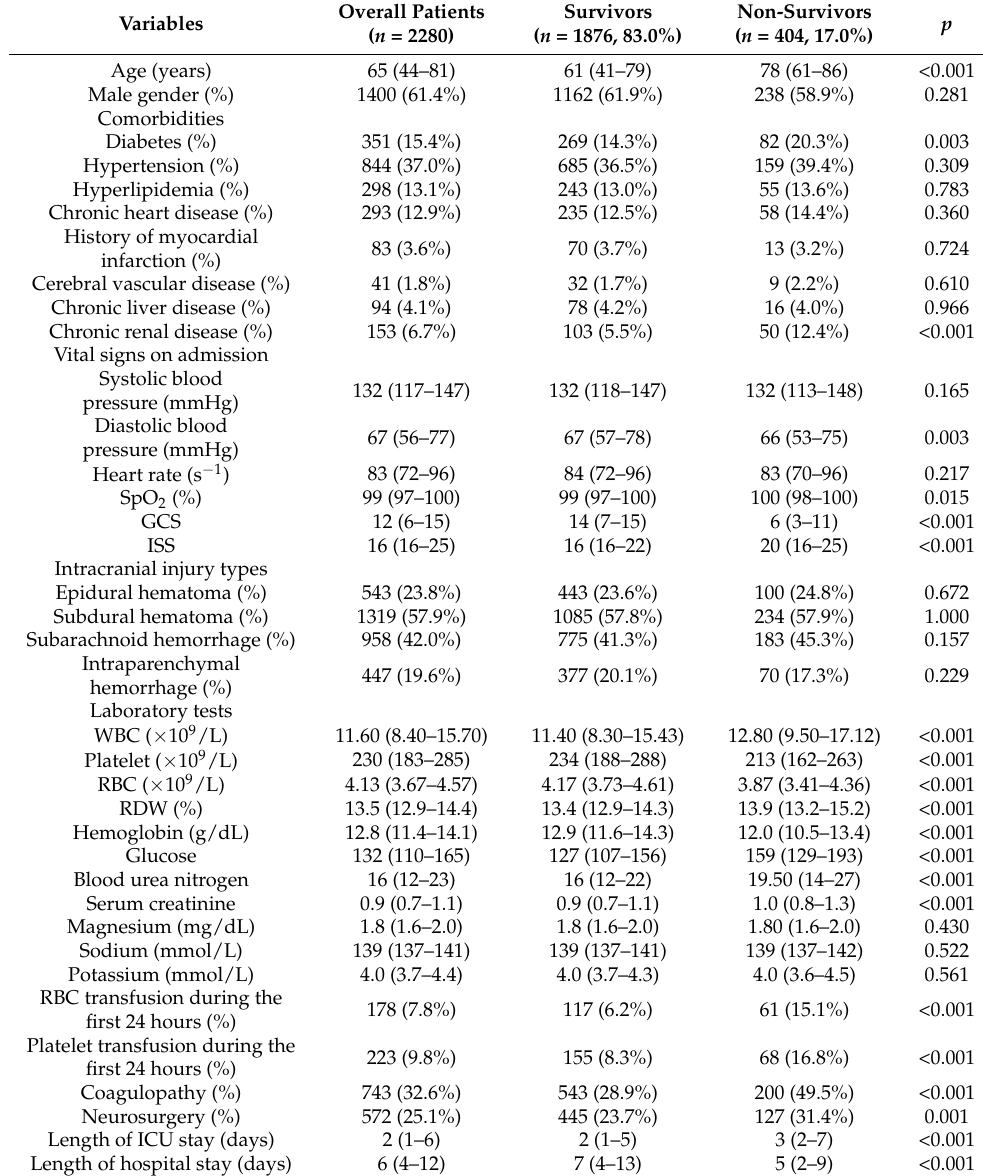
Table 1. Baseline characteristics of included TBI